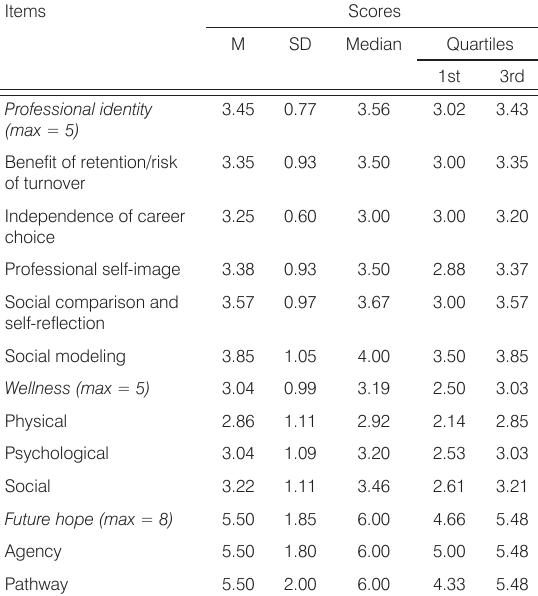
Table 2. Scores of professional identity, wellness, and future hope among nurse interns in the study sample (N = 210).